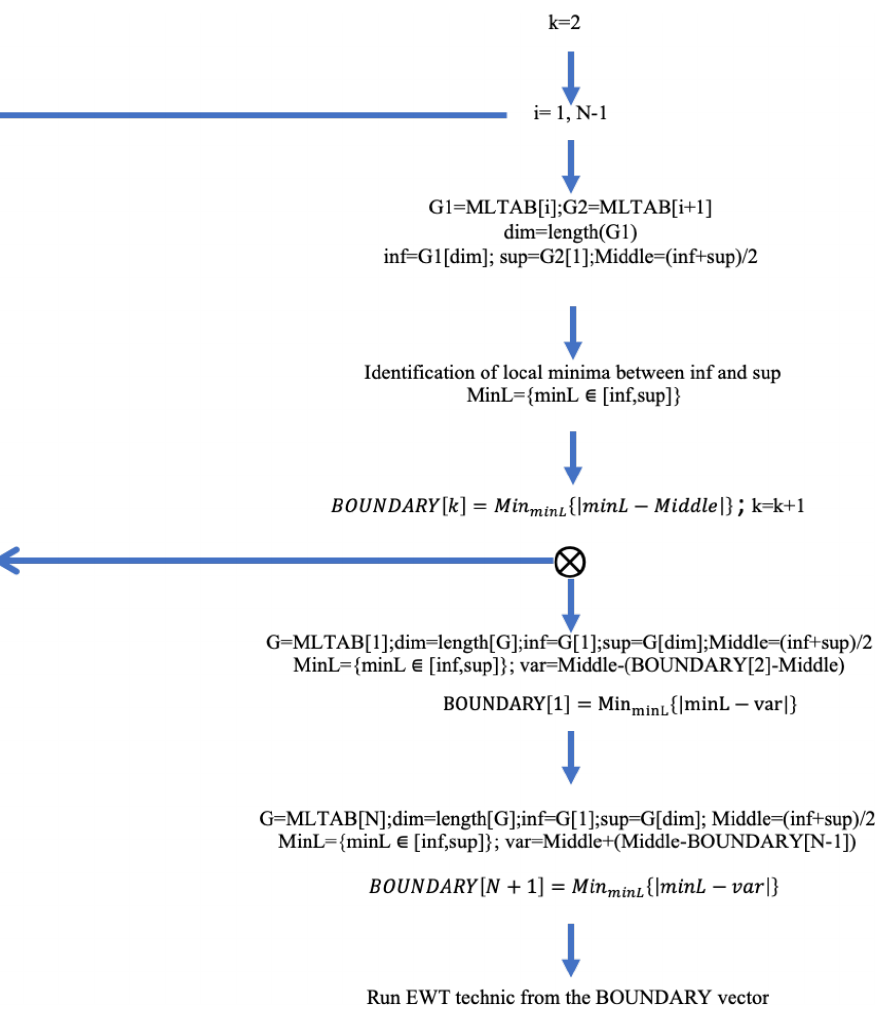
Figure 3. Calculation of the BOUNDARY vector representing the boundaries between the local maximum groups contained in the MLTAB matrix. The EWT technique is run from BOUNDARY.